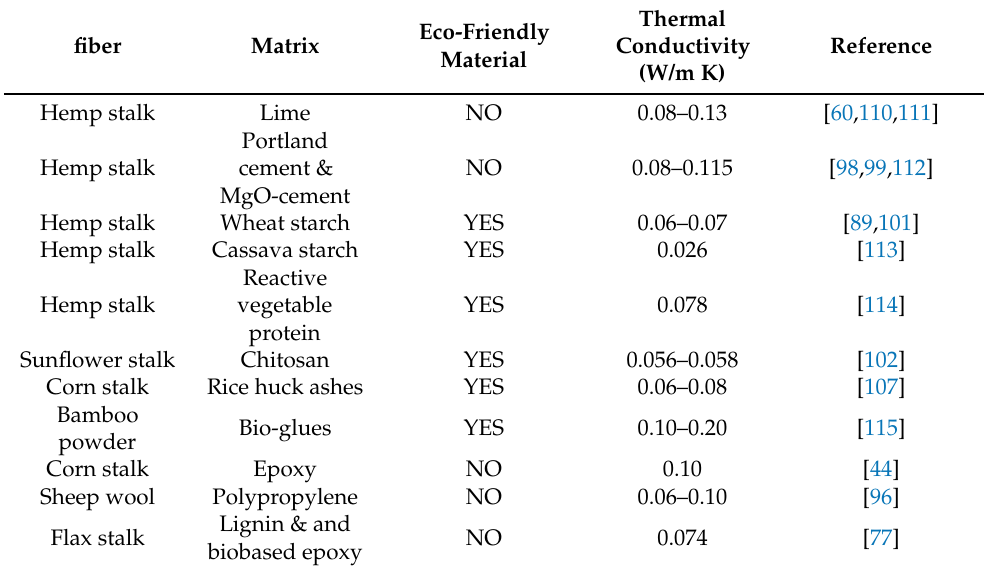
Table 5. Results of thermal absorption of vegetal particles with different